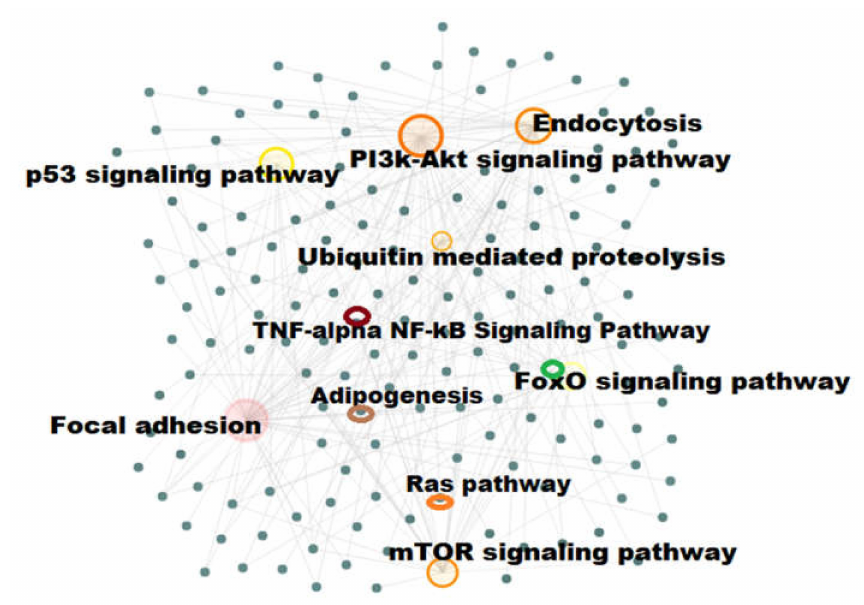
Figure 3. Functional pathway enrichment network analysis. The di ff erentially expressed genes (DEGs) involved various pathways like PI3K-Akt signaling pathway, focal adhesion, Ras pathway, endocytosis, p53 signaling, Adipogenesis pathway, mTOR signaling pathway, FoxO signaling pathway, ubiquitin-mediated proteolysis, TNF-alpha NF-kB signaling pathway respectively. The FDR < 0.05, p -value < 0.05 are considered as statistical significances.